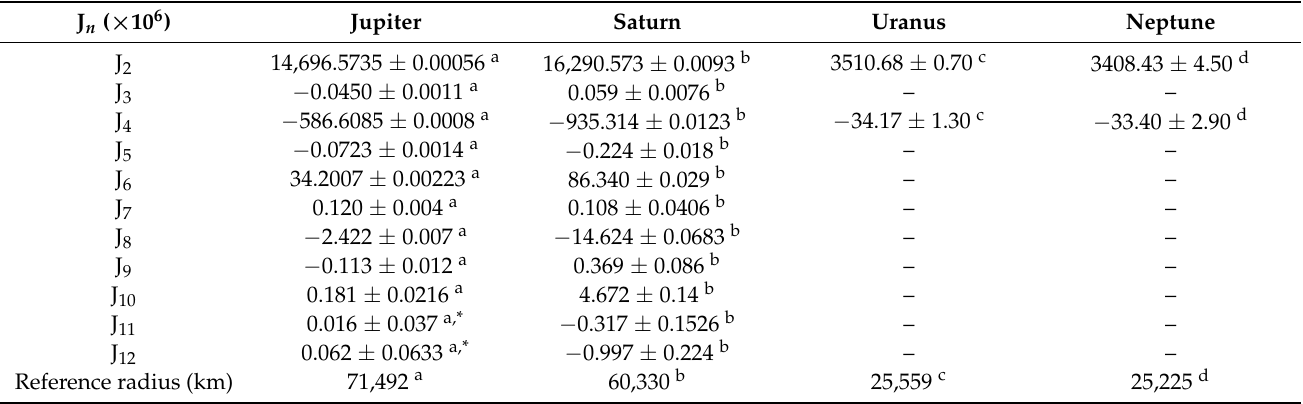
Table 1. Gravitational harmonics of the giant